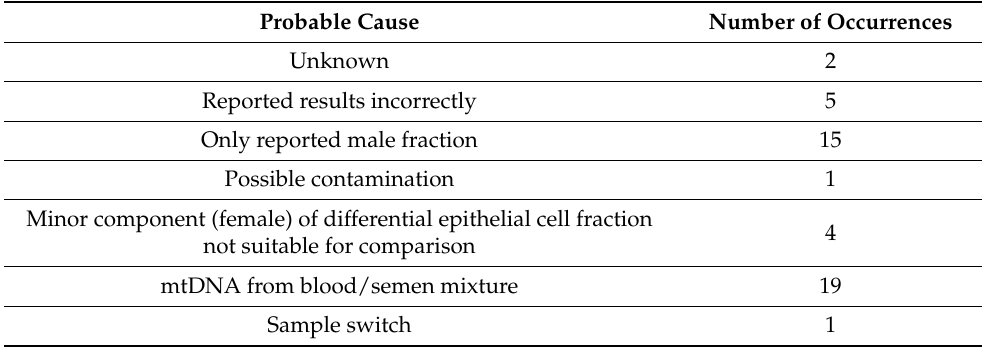
Table 2. The probable cause of the false positive and false negatives given in Table 1. These tally 47 instead of 49, because, in two instances, one occurrence led to both a false positive and a false negative.